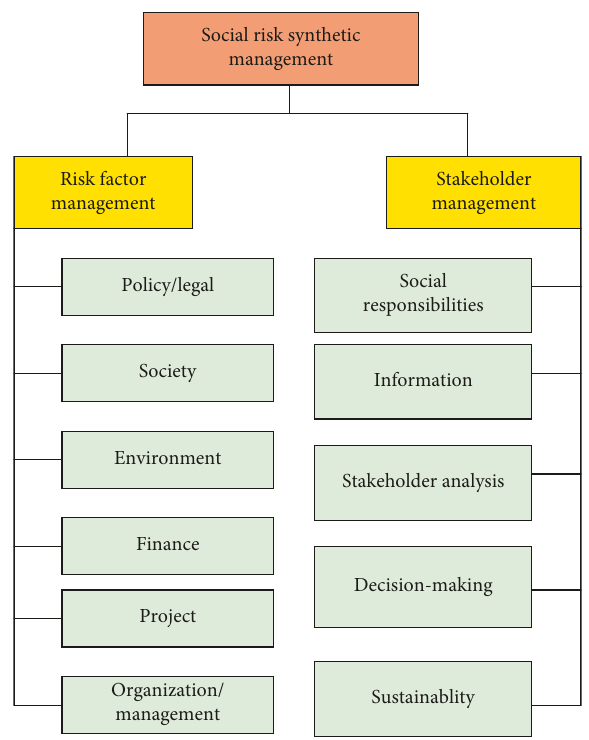
Figure 3: Social risk synthetic management